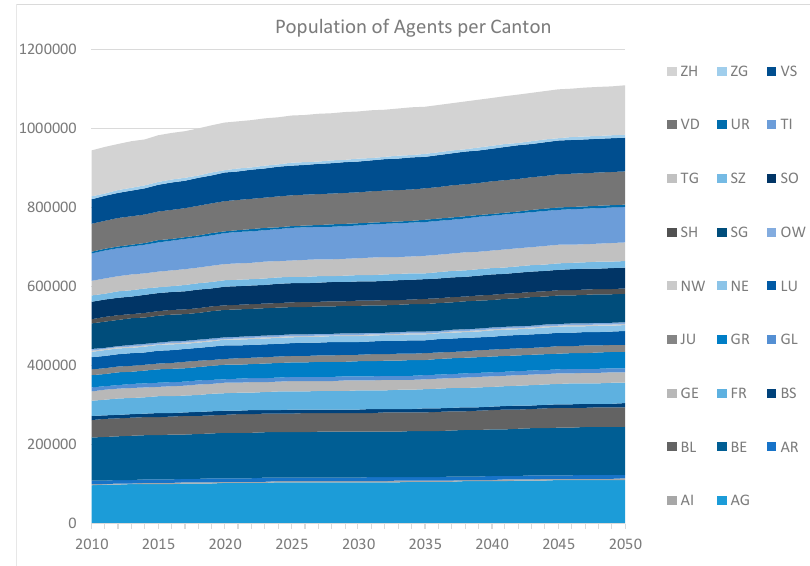
Figure 4. Assumed evolution of the agents in the model, per Swiss